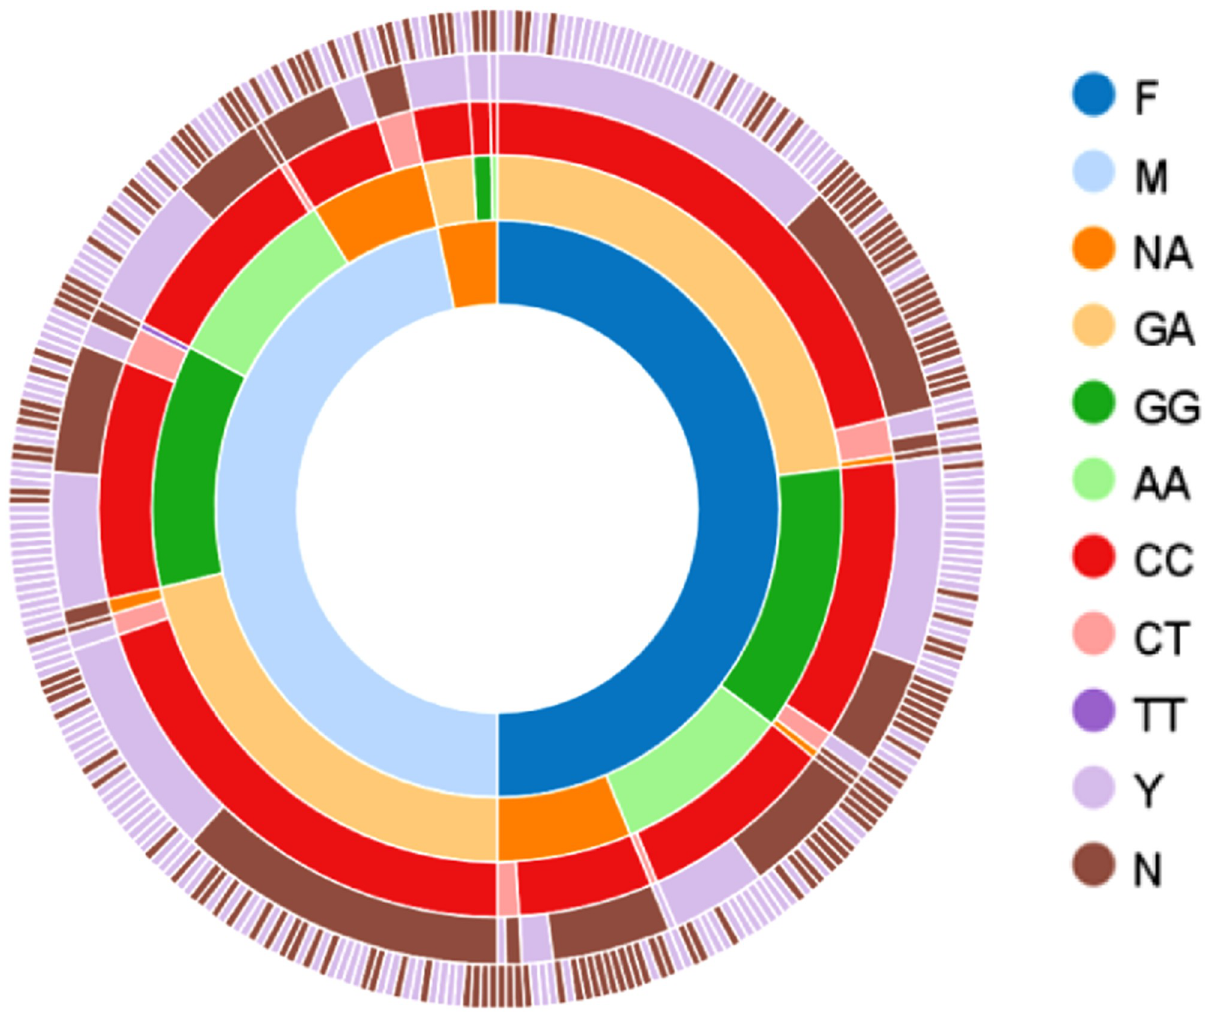
Fig 2. Sunburst figure shows the distribution of all samples ( n = 350) among different categories. The first inner circle indicates the gender (175 females (F), 163 males (M), and 12 not available (NA)), while the second and third circles show different genotypes of rs1761667 ( n = 310) and rs1527483 ( n = 347), respectively. The fourth and fifth ones represent diabetes (yes (Y) = 177, and no (N) = 173) and dyslipidemia (Y = 201, and N = 149) status,